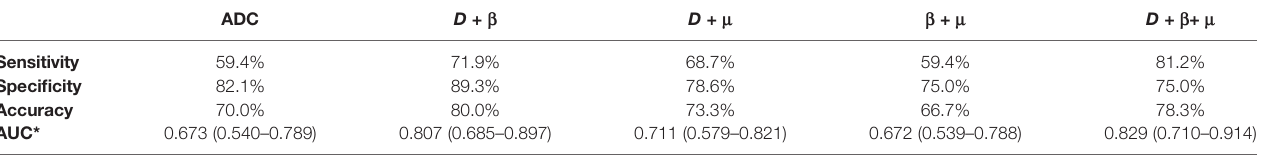
TABLE 5 | The ROC analysis results of using ADC and the combinations of the FROC model parameters to differentiate low-grade tumor from high-grade tumor. ADC D + b D + m b + m D + b + m